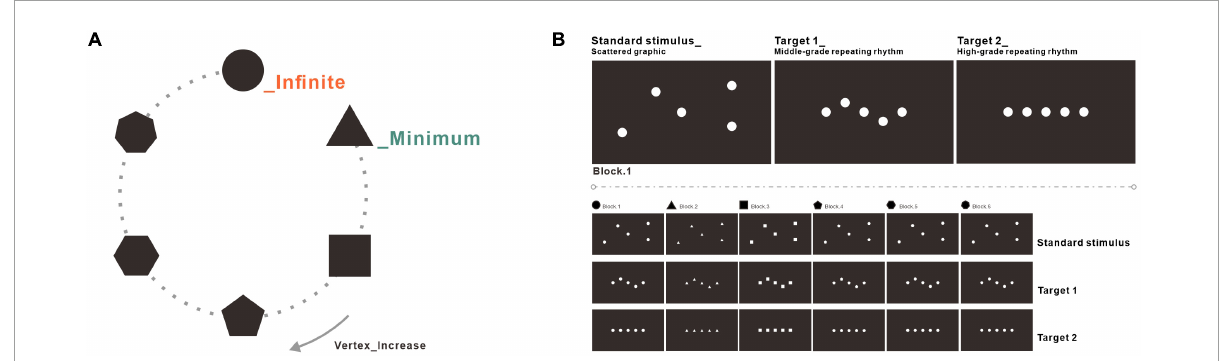
FIGURE2 Stimuli used in the experiment. (A) The stimuli were composed of basic patterns with increasing vertexes, including circles, triangles, squares, pentagons, hexagons, or heptagons. (B) The standard stimulus was composed of scattered graphics with the lowest orderliness level. Target 1 was composed of the regular graphic within the middle-grade repeating rhythm. Target 2 was composed of a perfectly arranged graphic within the high-grade repeating rhythm.